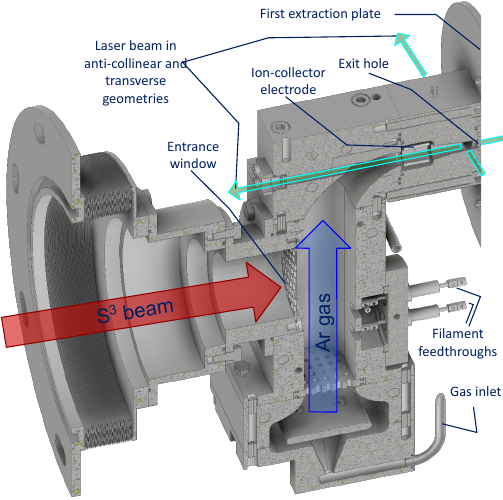
Figure 1. 3D cross-sectional view of the S 3 -LEB gas